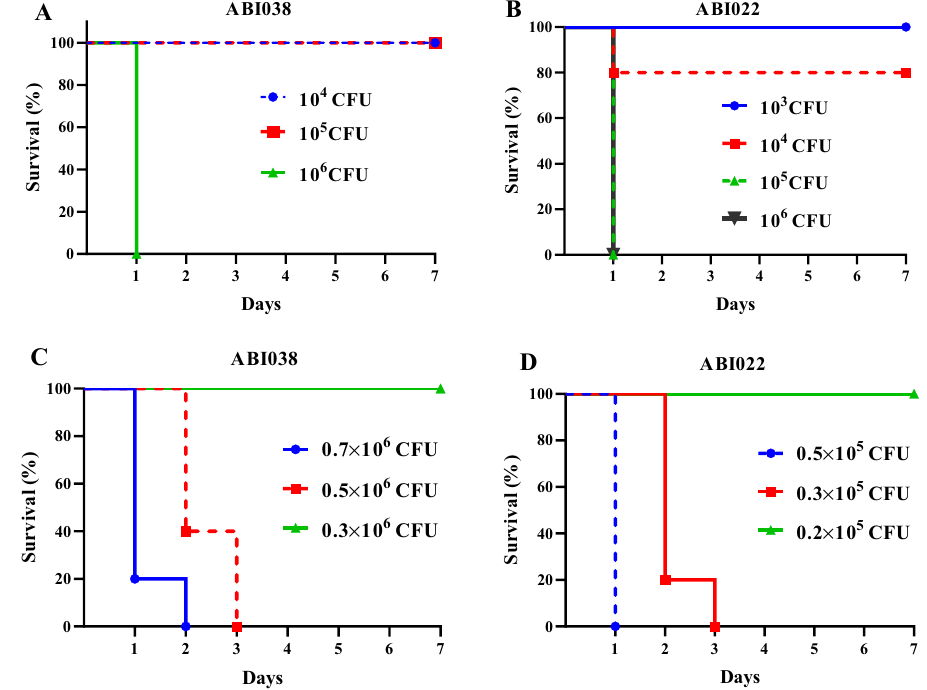
Figure 6. Determination of minimal lethal dose (MLD) and sub-lethal dose (SLD) of clinical isolates. ( A , B ) The lethal dose of clinical strains of ABI038 and ABI022 were 10 6 and 10 5 , respectively. ( C ) MLD and SLD of ABI038 were determined as 0.7 × 10 6 and 0.5 × 10 6 , respectively. ( D ) MLD and SLD of ABI022 were determined as 0.5 × 10 5 and 0.3 × 10 5 ,